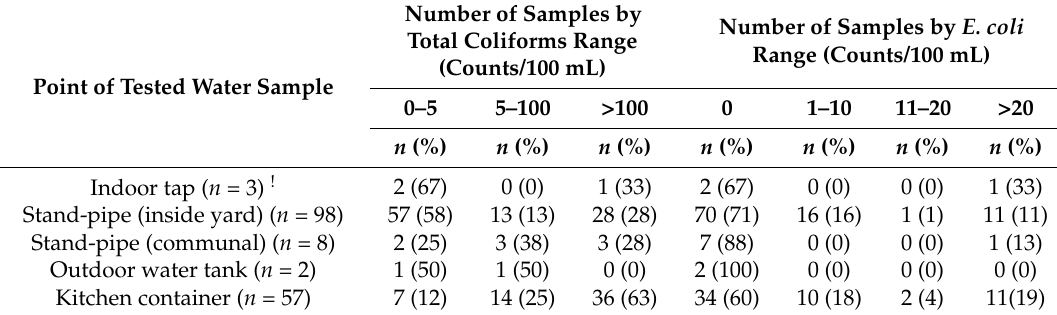
Table 4. Results of the tests for presence of total coliforms and E. coli in water sampled from accessible water points in a sub-sample ( n = 192) of water points used by households.